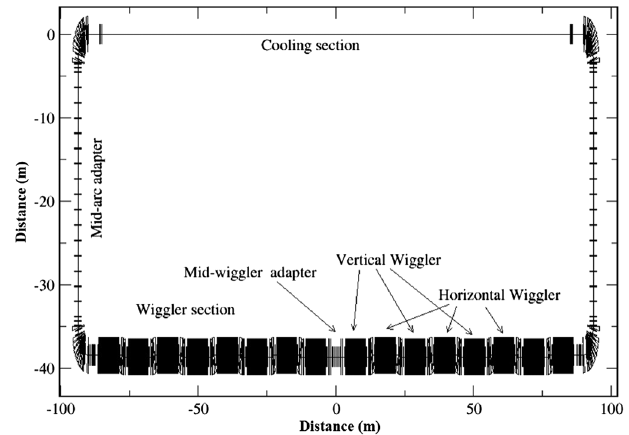
FIG. 2. Layout of the ring